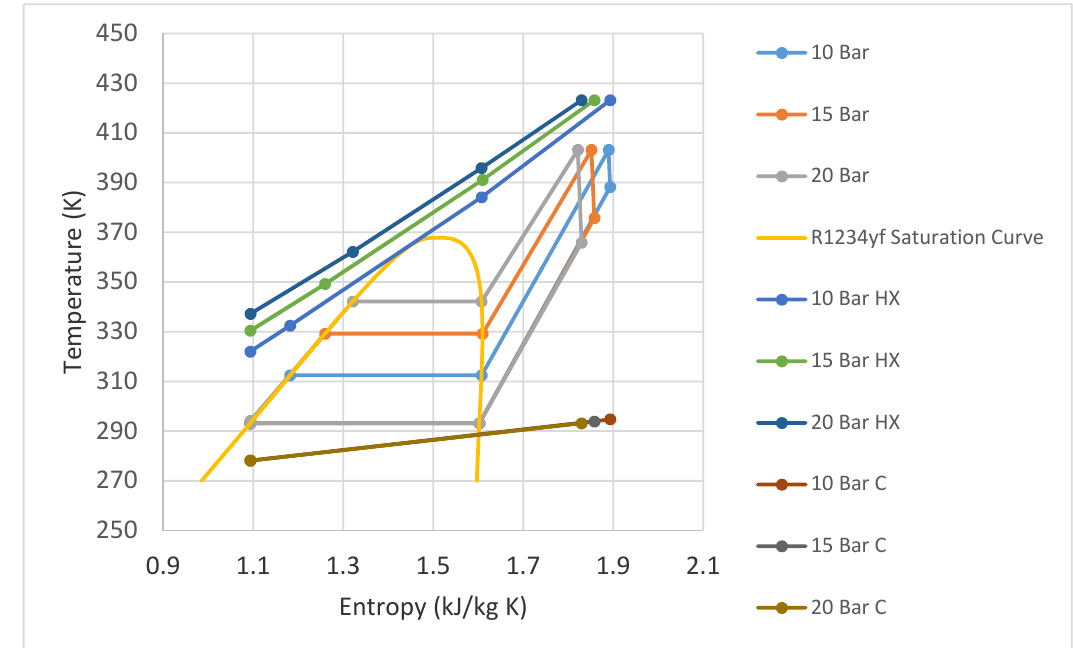
Figure 2. Temperature-Entropy chart for the three Rankine cycles and the corresponding details of the circulating water (hot HX, cold C).